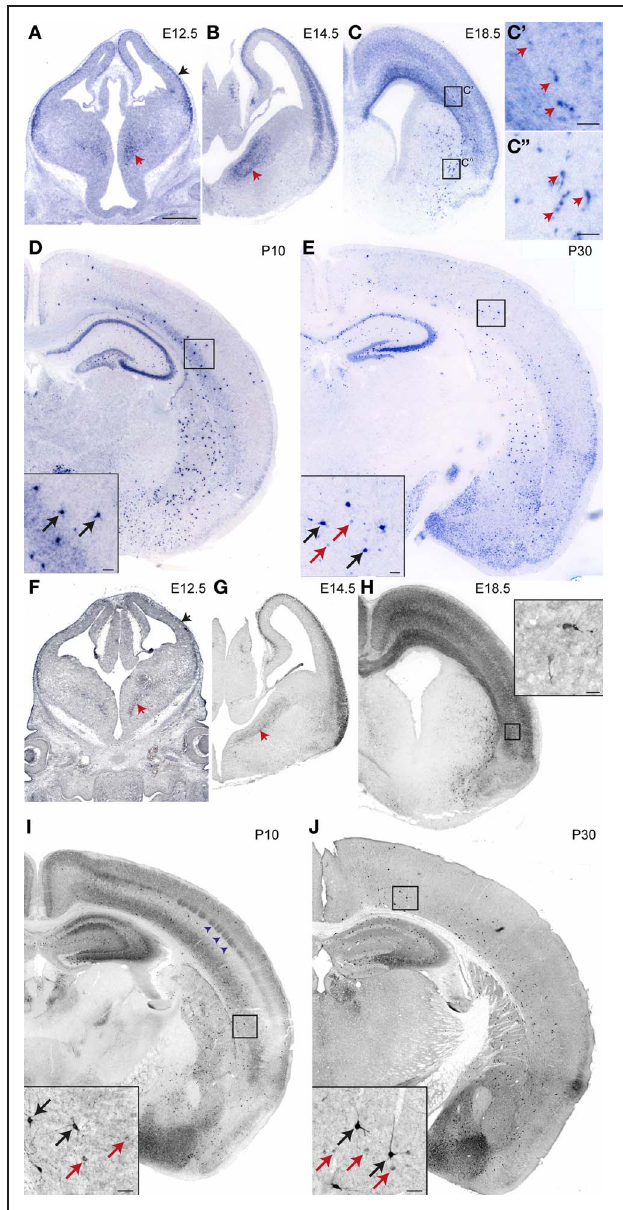
FIGURE 1 | Developmental expression of nNOSin theneocortex. (A–E) nNos mRNAexpression at different embryonic and postnatal stages. Black and red arrowheads in (A) and (B) point to expression in the superficial cortex andtheventral MGE,respectively. Arrowheads in (C’) and (C”) pointto cells expressing high levels of nNOS in the cortex and striatum, respectively. (F–J) nNOS protein expression at different embryonic and postnatal stages. Type I and type II cells are marked by black and red arrows, respectively in (I) and (J) .Scalebars: A–J ,500 μ m. C,C” andinsertsin D , E , I , J ,50 μ m.Insertin H , 20 μ